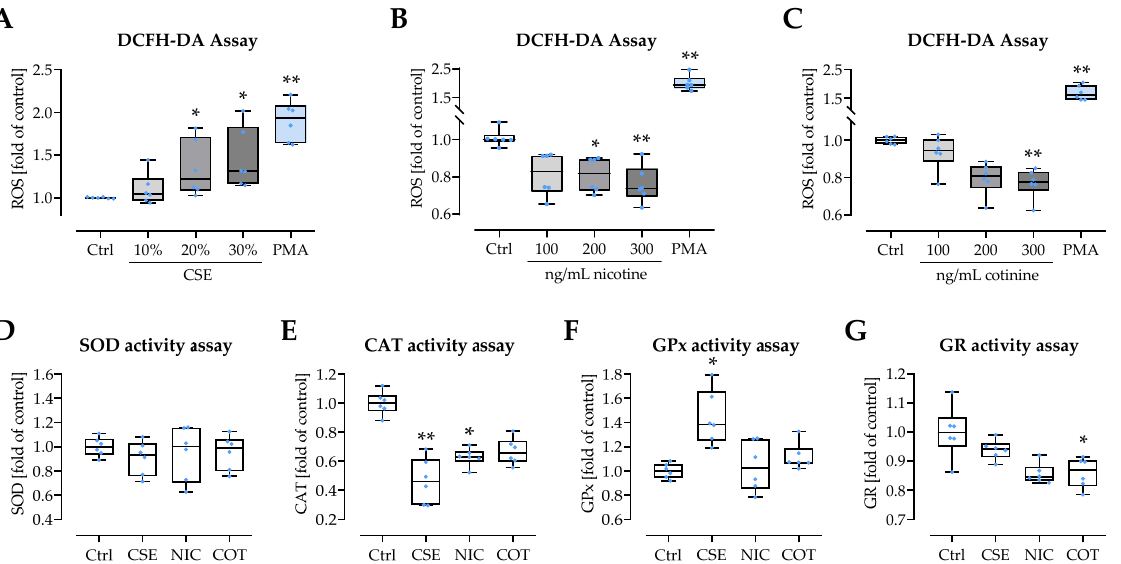
Figure 6. Influence of CSE, nicotine, and cotinine on neutrophilic ROS formation and anti-oxidative defense mechanisms. Neutrophils were isolated from healthy volunteers, loaded with DCFH-DA, and then stimulated with freshly prepared ( A ) CSE (10, 20, and 30%), ( B ) nicotine (100, 200, and 300 ng/mL), or ( C ) cotinine (100, 200, and 300 ng/mL) to quantify formed ROS. The effects of 20% CSE, 200 ng/mL nicotine (NIC), or 200 ng/mL cotinine (COT) on the activity of isolated (synthetic) enzymes of the anti-oxidative defense were determined. Enzyme activities analyzed were ( D ) superoxide-dismutase (SOD), ( E ) catalase (CAT), ( F ) glutathione peroxidase (GPx), and ( G ) glutathione reductase (GR). ( N = 6, n = 6). Data are presented as box blots with individual measurement points, median, and interquartile range. Groups were compared by non-parametric Kruskal–Wallis test followed by Bonferroni multiple comparison test. * p < 0.05 and ** p < 0.01 as compared to the respective control group (Ctrl). 3.6. CSE, Nicotine and Cotinine Affect the Activity of Enzymes Involved in NET Formation As CSE, nicotine, and cotinine inhibited the activity of several anti-oxidative enzymes, their effect on the activity of enzymes involved in NET formation was measured. PADI4 activity was enhanced significantly by CSE (+42%), and tendentially by nicotine (+42%) and cotinine (+25%/Figure 7A). While MPO activity seemed to be inhibited by CSE ( − 22%), it was tendentially enhanced by nicotine (+57%) and cotinine (+20%/Figure 7B). ELANE activity was inhibited by CSE ( − 33%), nicotine ( − 31%), or cotinine ( − 41%/Figure 7C).